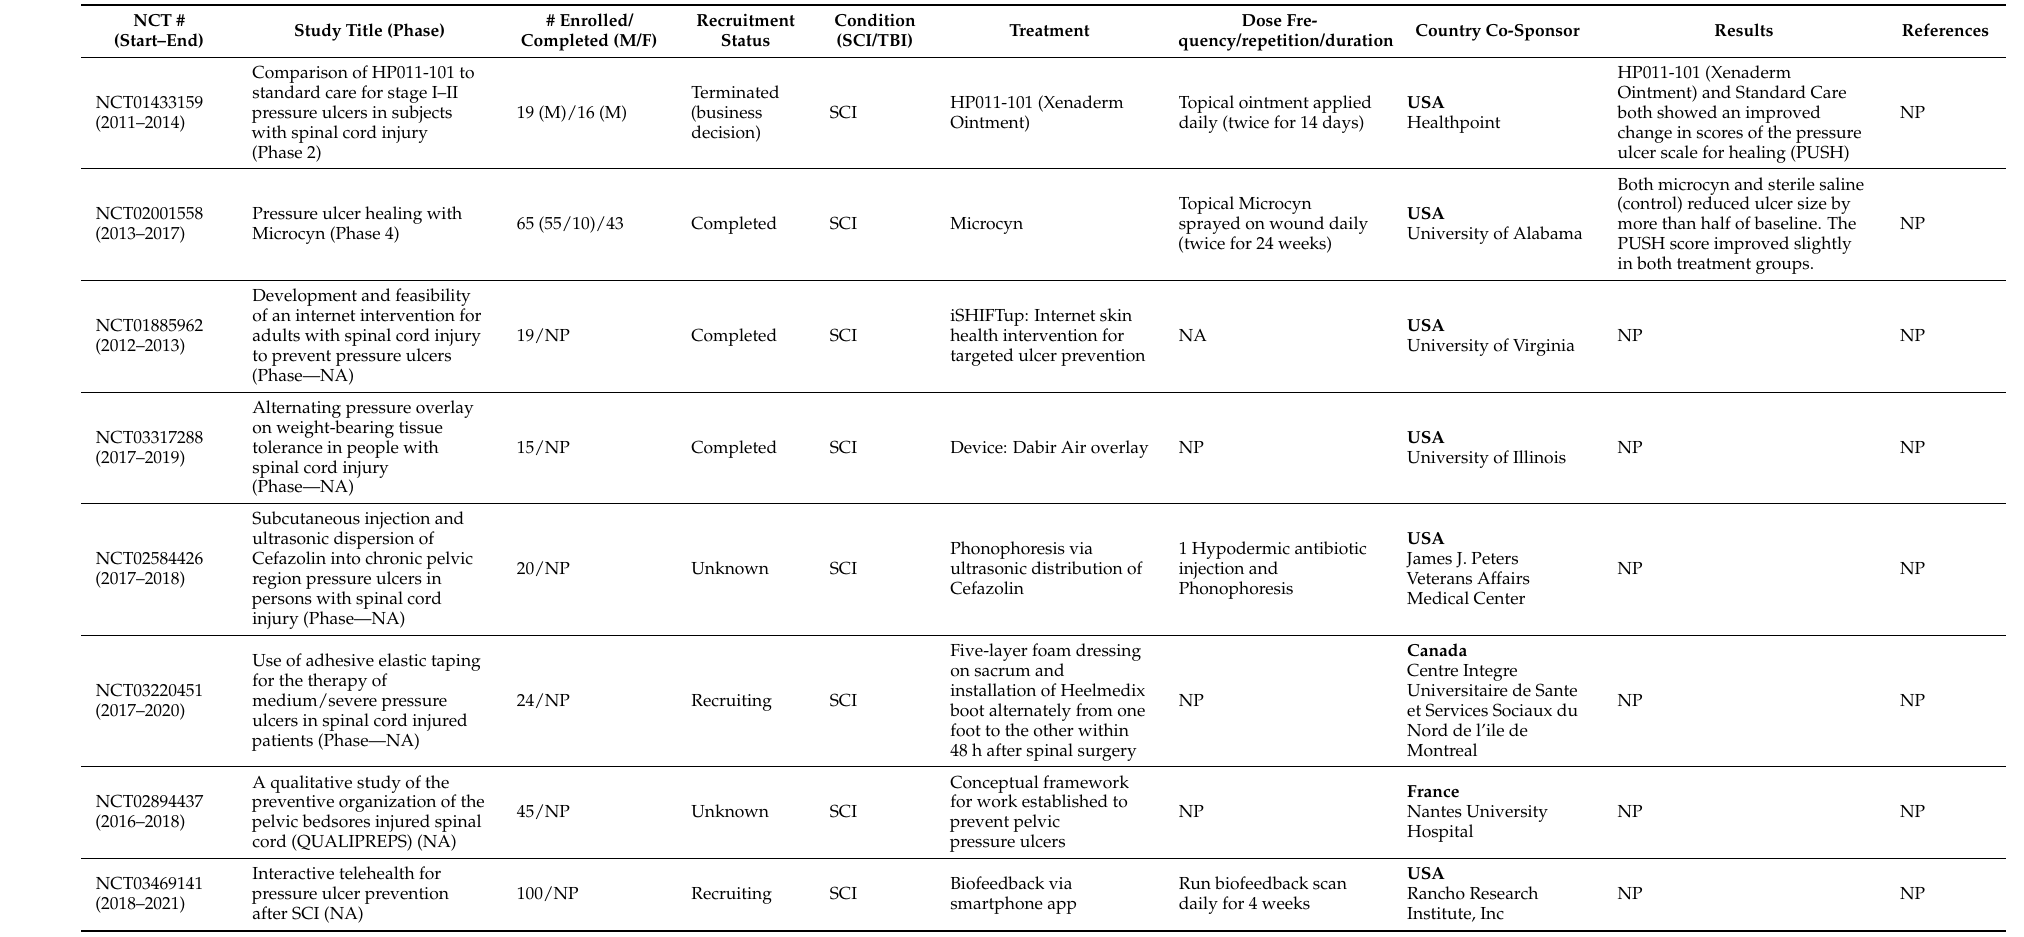
Table 2. Incomplete or Complete Clinical trials for PU/skin wound in the SCI and